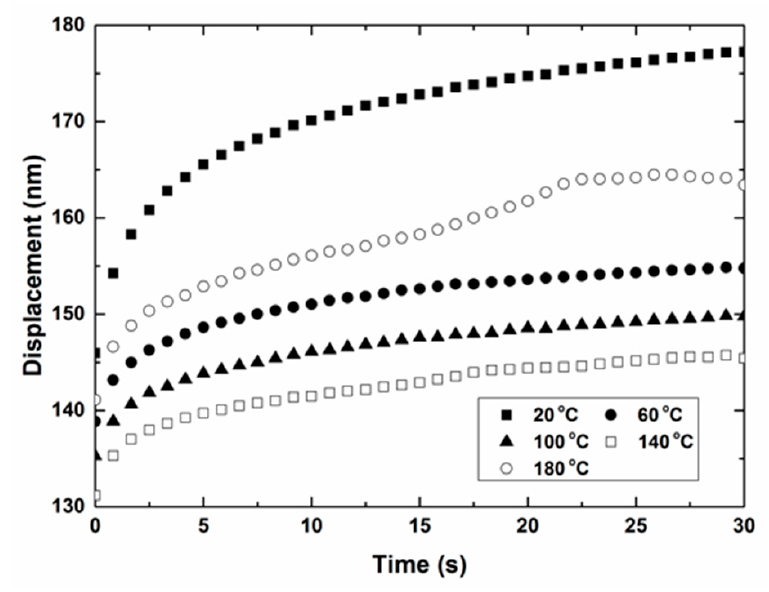
Figure 6. The creep displacement of untreated wood cell wall.